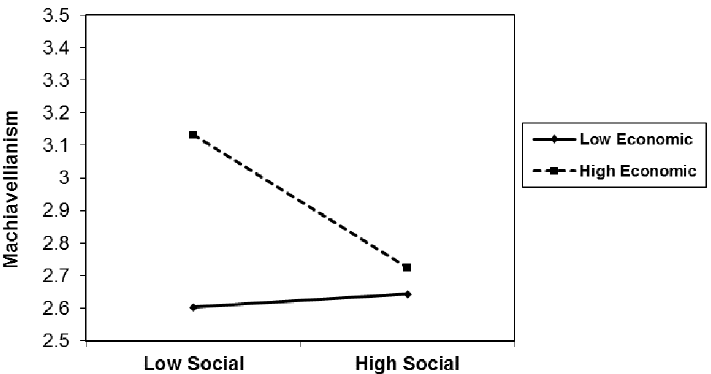
Figure 3. The Study 2 interaction between social and economic political ideology (measured via single-item measures) in relation to